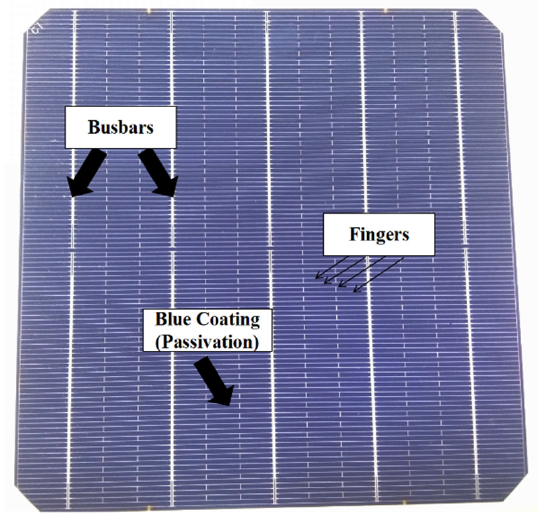
Figure 2. Image of a completed solar cell.